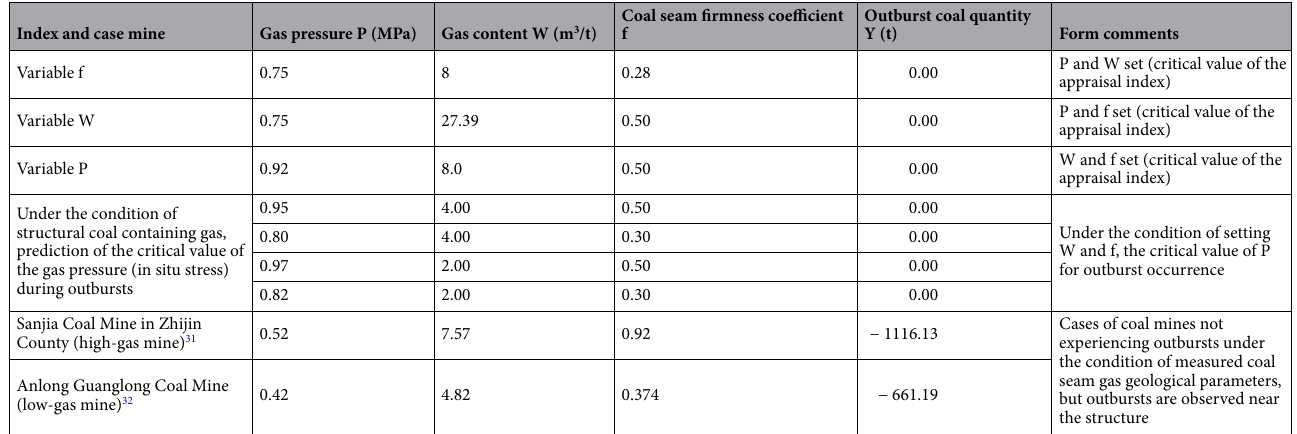
Table 2. Critical values of the outburst influencing factors under the different parameter